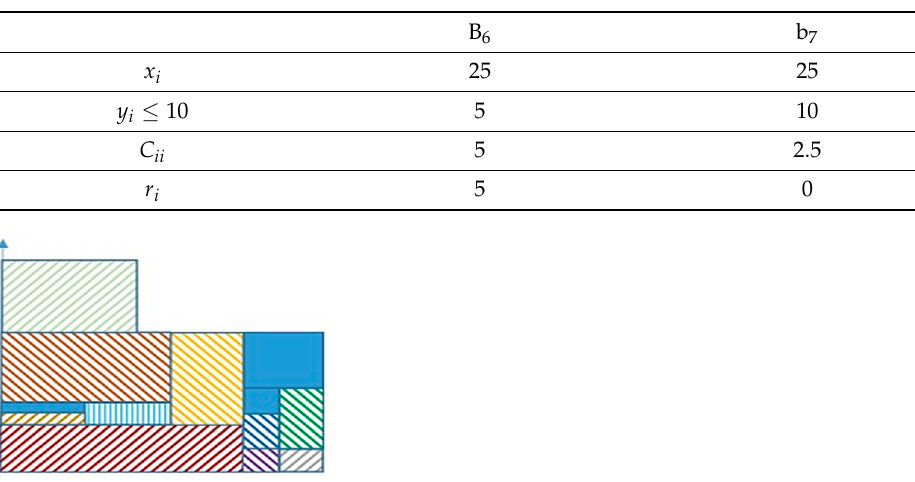
Figure 10. Improve the shortest depth branch.